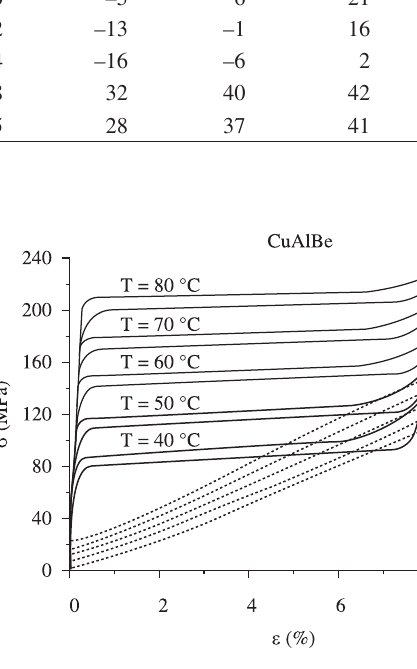
Figure 1. Effect of temperature in the electro-thermomechanical properties of the superelastic tests (CAB10).